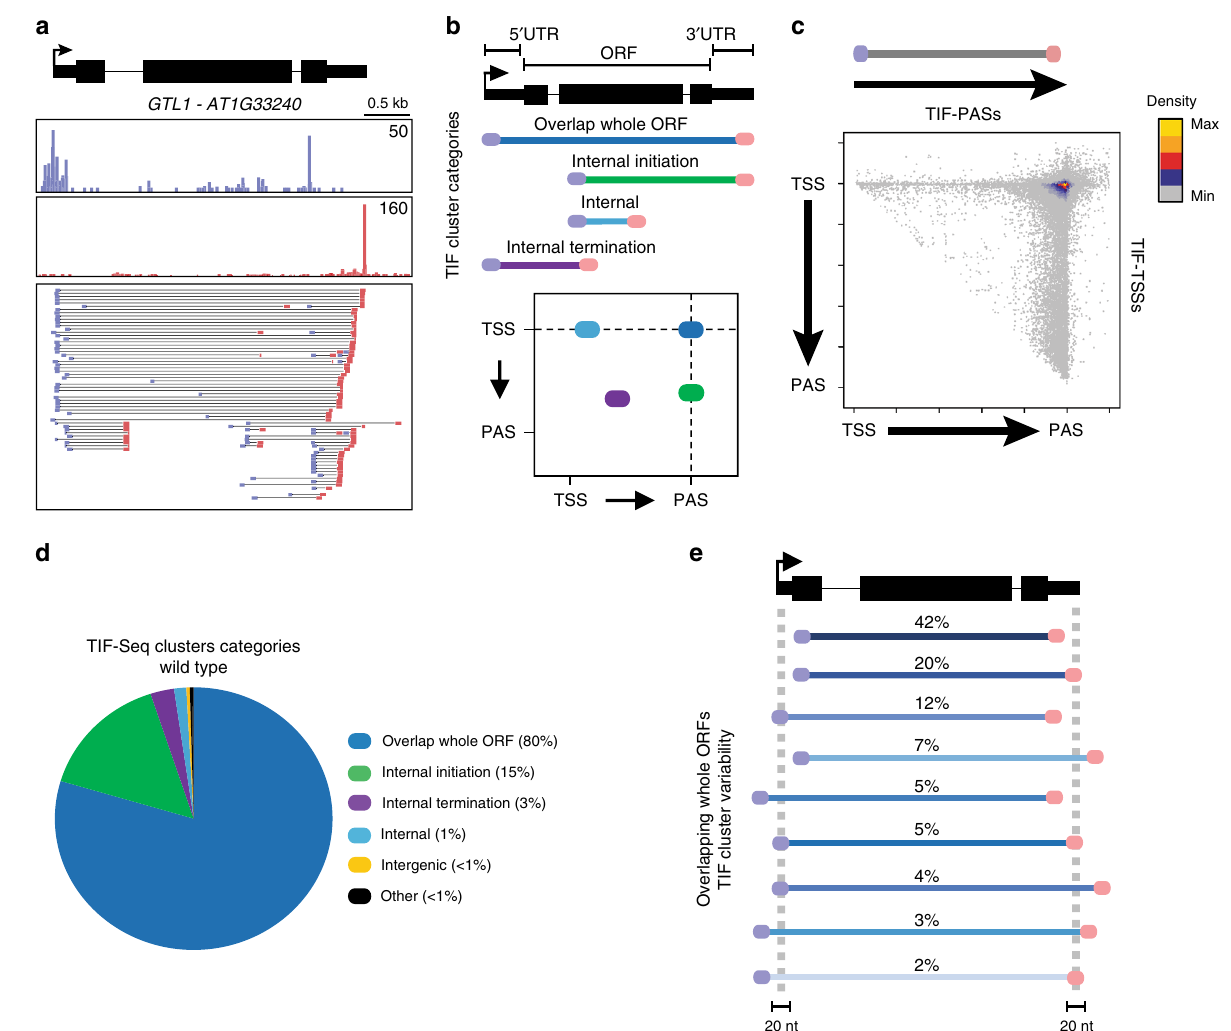
Fig. 1 Mapping TU boundaries in Arabidopsis by TIF-seq. a Genome browser screenshot of TSSs (TSS-seq) 35 , PASs (Direct RNA-seq; DR-seq) 73 , TSS/ PAS pairs (TIF-seq) and TIF-clusters at the GTL1 gene. b Schematic of TIF-TSS/PAS pairs representing different TIF-cluster categories and 2D illustration of these positions (blue circles are TSSs and red circles PASs) with respect to genome annotations. Each line and its colour correspond to the coloured circles in the schematic scatterplot. c Scatterplot of TIF-cluster TSS/PAS pairs in wild type. Each point represents one TIF-seq cluster and its TIF-TSS and PAS distance to respective annotated gene boundaries and normalised to gene length. The colour scale represents 2D position enrichment density of clusters from low (grey) to high (yellow). d Pie chart of TIF-cluster categories proportions present in wild type. e Schematic representation and percentage of subcategories for TIF-clusters overlapping whole ORFs. Source data of d and e are provided in the Source Data fi